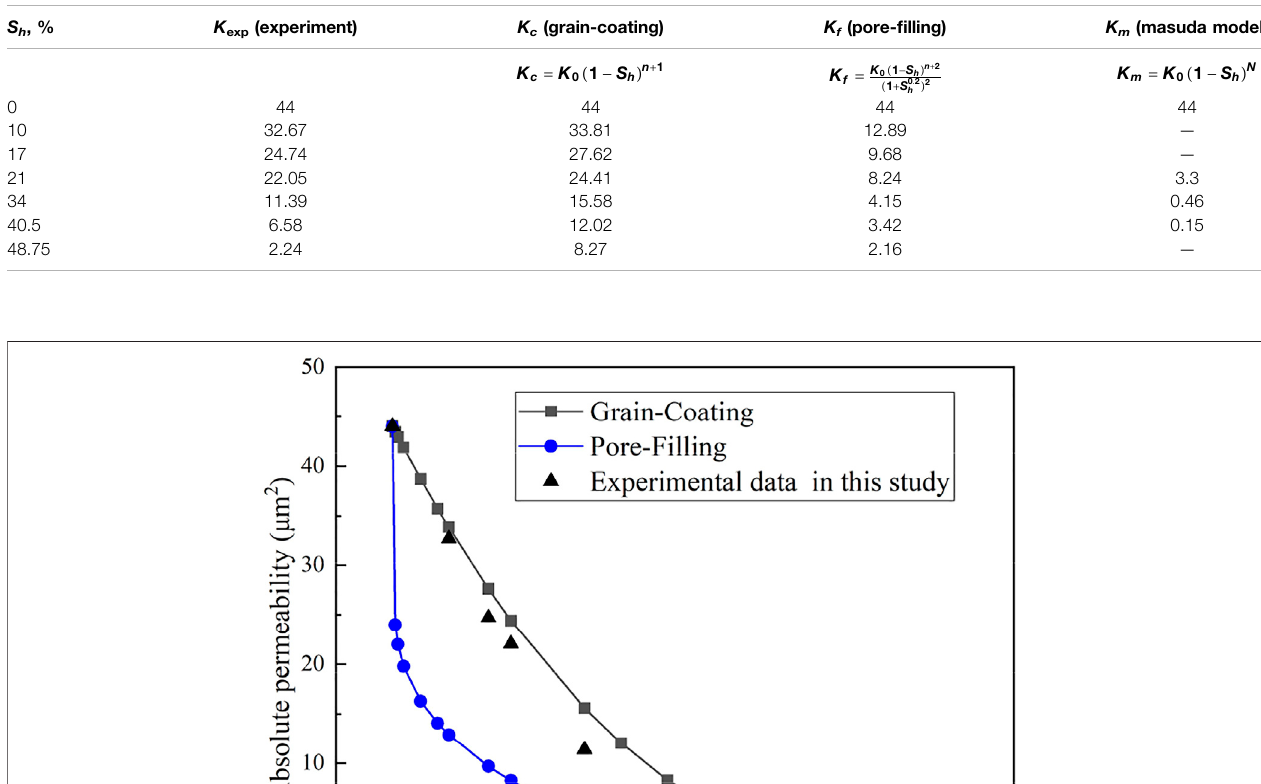
TABLE 2 | Comparison of the different permeability models with the experimental results.